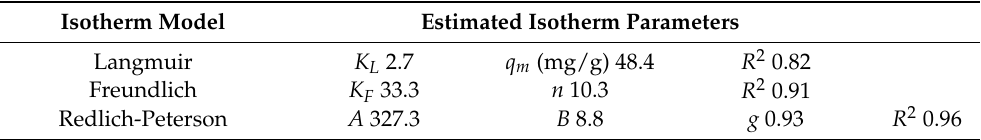
Figure 10. The nonlinear fitting results by Langmuir, Freundlich, and Redlich-Peterson isotherms sorption models. Table 2. Ion-exchange adsorption constants obtained by fitting isotherm data with different Langmuir, Freundlich, and Redlich-Peterson